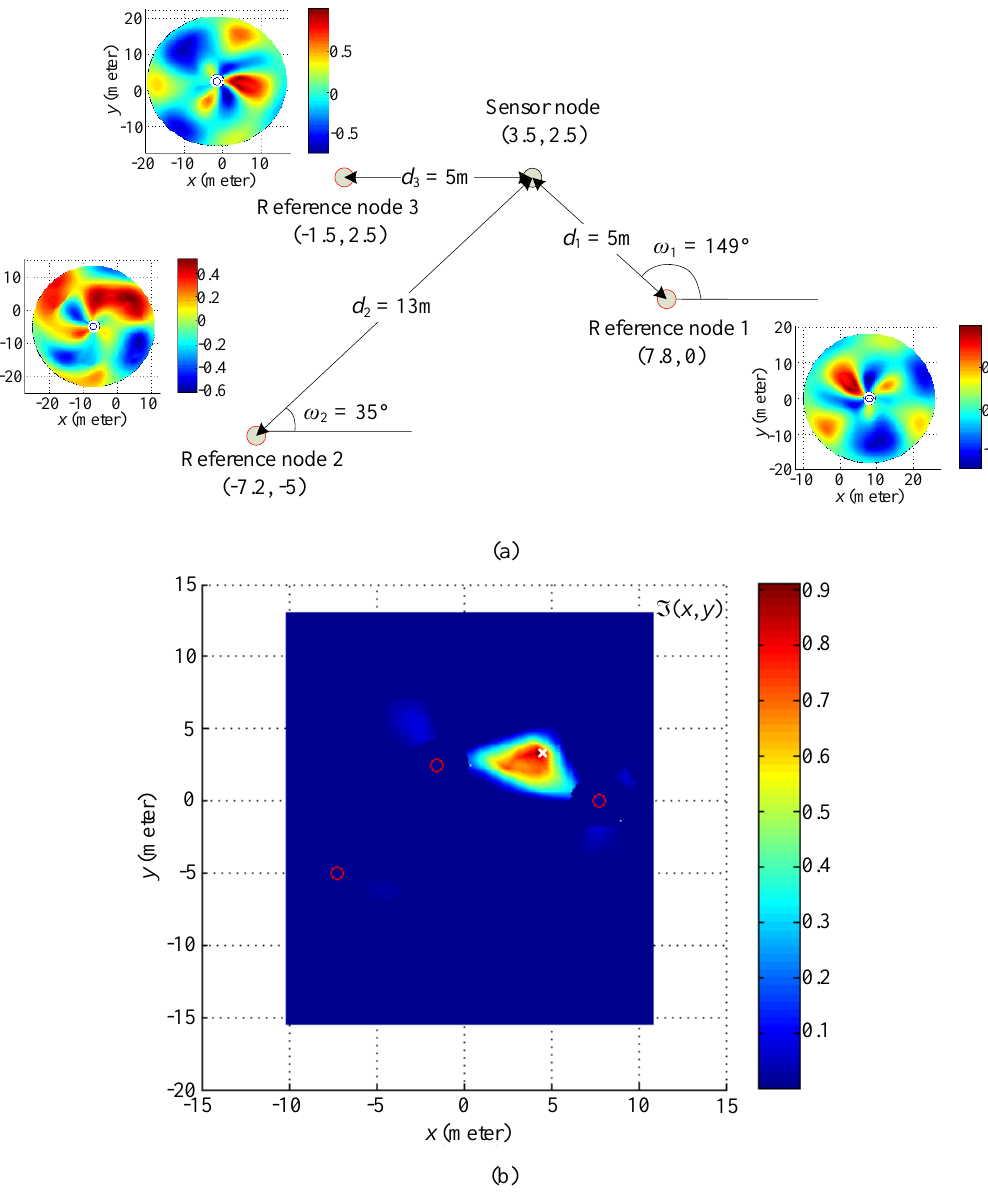
Figure 15. Experimental result for three reference nodes scenario. (a) Deployment arrangement of the sensor node and reference node in the scenario for three-reference nodes. (b) Overall solution space with coordinates of reference nodes (red circles ○) and estimated coordinate (white cross × ) of the sensor